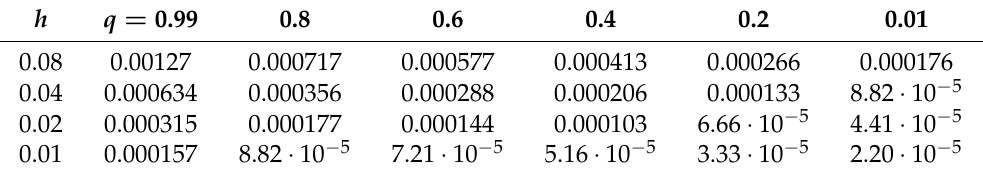
Table 1. Average absolute errors for the problem with a constructed analytical